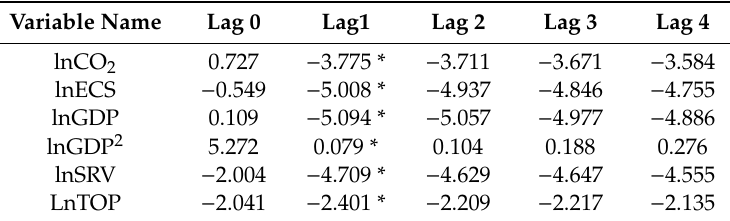
Table A1. Lag length determination.